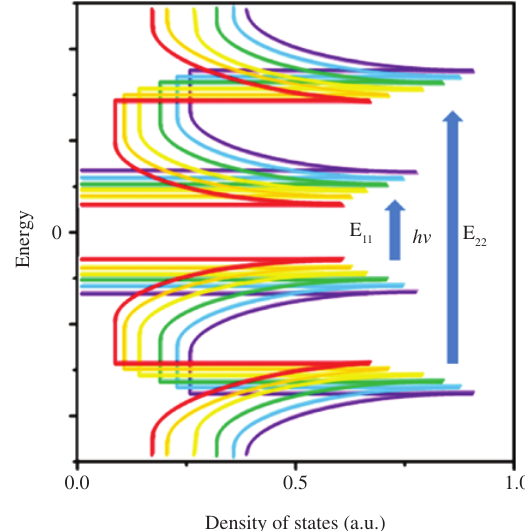
Figure 1: Typical electronic structure of the mixed CNTs.